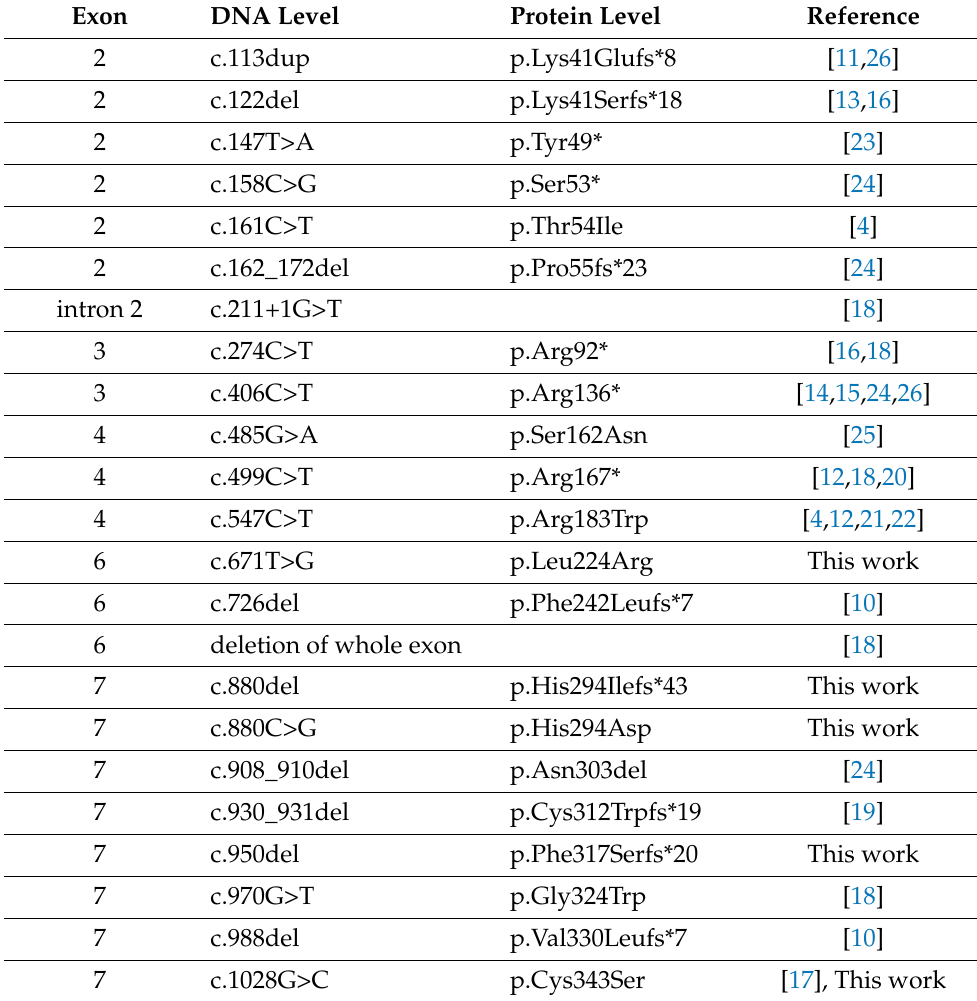
Table 3. Pathogenic variants reported to date in PJVK